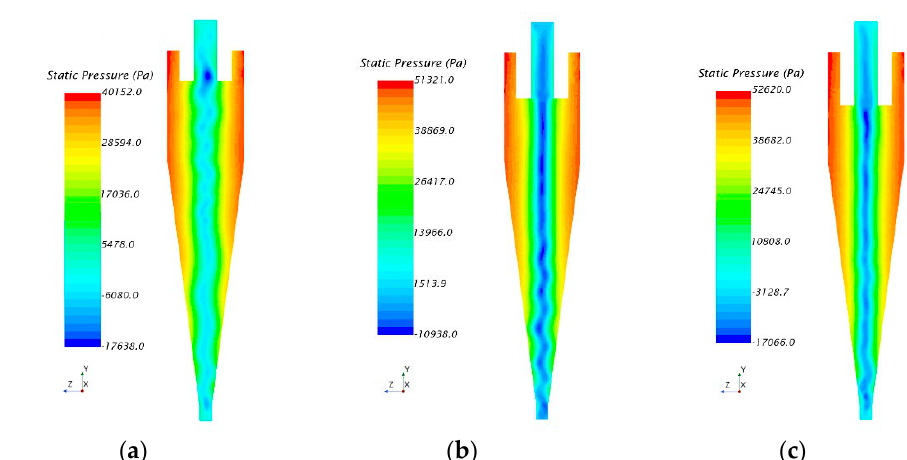
Figure 8. Static pressure at 60 s at an inlet feed velocity of 5 m/s ( a ) VF = 20 mm ( b ) VF = 30 mm ( c ) VF = 35 mm.